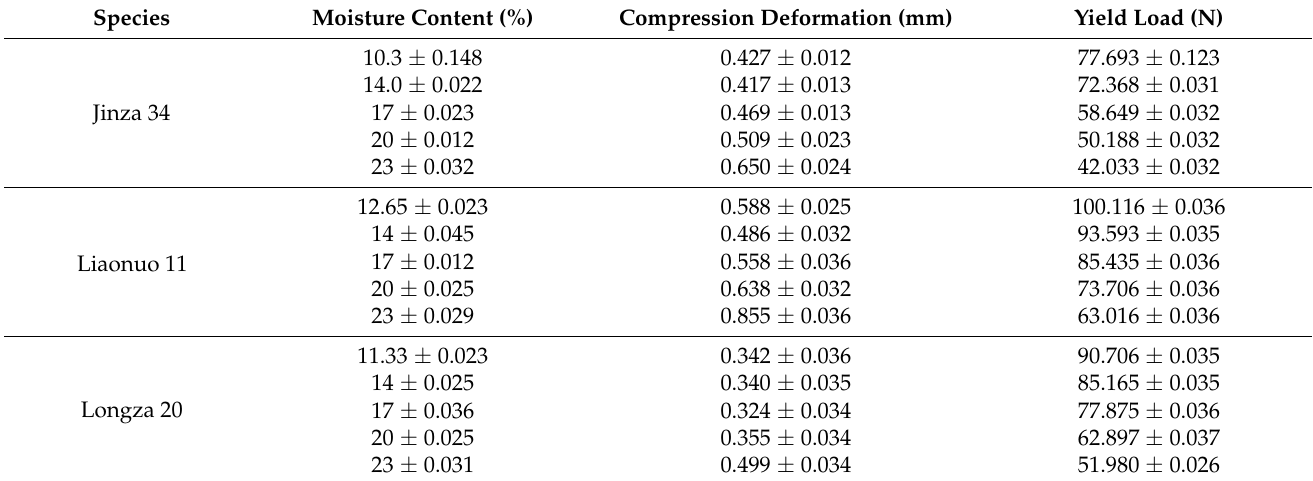
Table 4. Results of sorghum seed compression